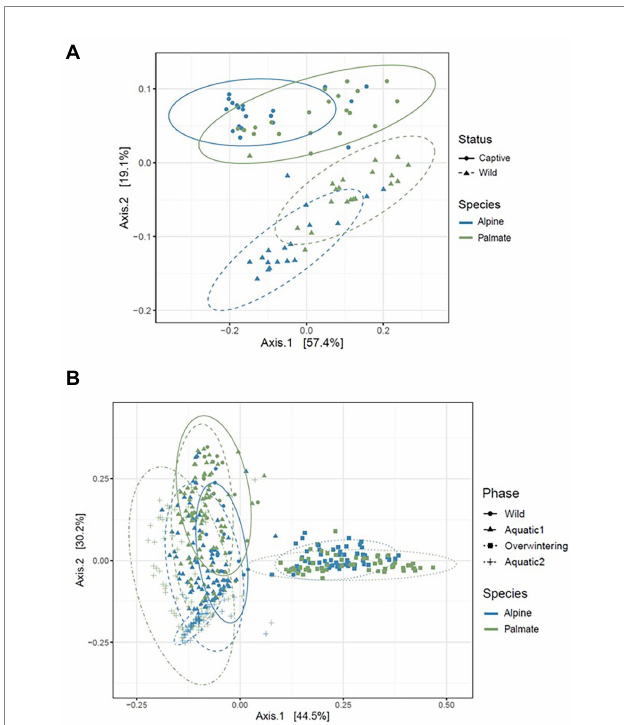
FIGURE 5 PCoA representing the beta diversity (calculated as the weighted Unifrac distance) of the skin microbiota of alpine and palmate newts, sampled in the wild and after 1 month in captivity (A) , and throughout all experimental phases (B) . Each dot represents the diversity of a microbiota sample. The species of each newt is indicated by the hue of its datapoint, and the phase of sampling is indicated by the shape of the datapoint as well as the line-type of the